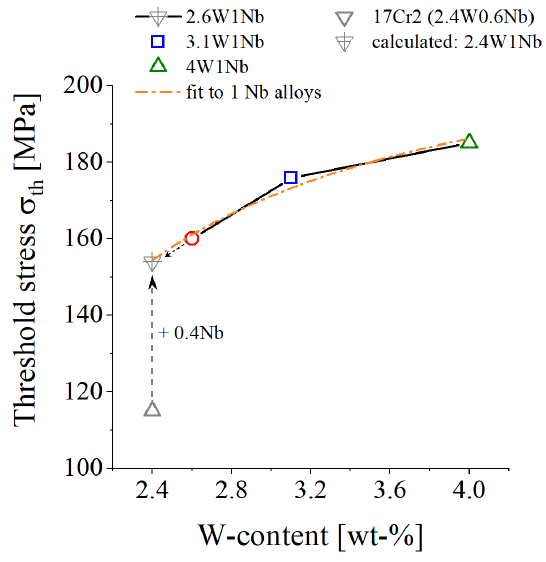
Figure 3. Impact of W and Nb on the threshold stress σ th [31].